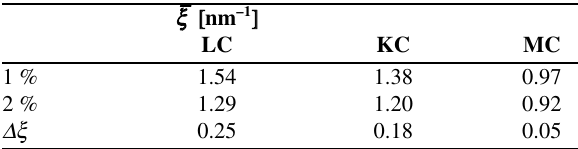
Table 1. The average values of the dynamic correlation length ξ for 1 and 2 wt. % viscous solutions of LC, KC, and